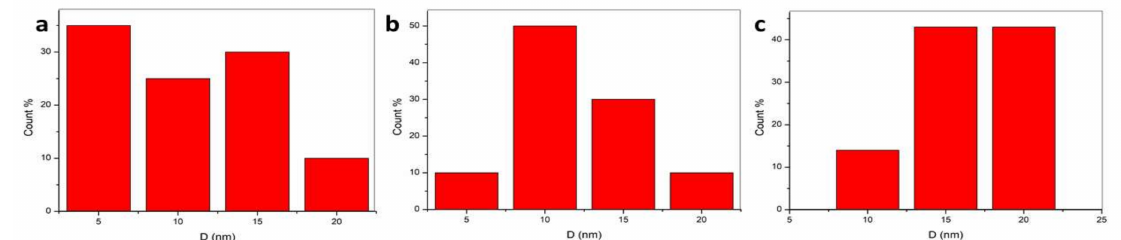
Figure 12. Particle size distribution of Ni/MgAl 2 O 4 sulfided with DMSO (S3) at ( a ) 200 ◦ C, ( b ) 400 ◦ C, and ( c ) 550 ◦